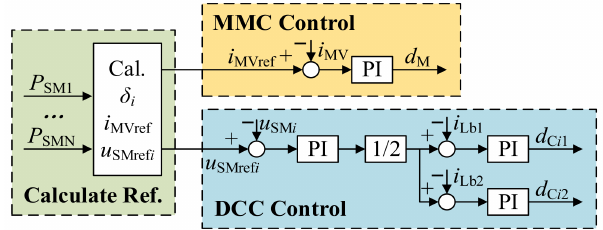
Figure 3. Block diagram of DCC-driven